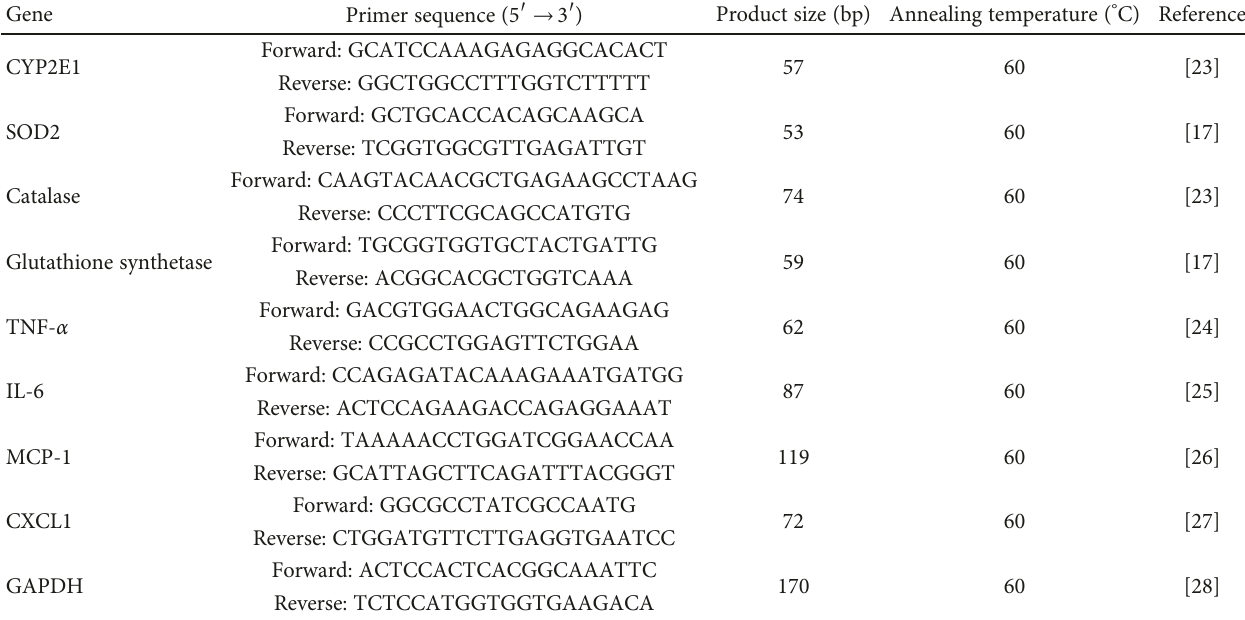
Table 1: Primers used for quantitative real-time RT-PCR. Gene Primer sequence (5 ′ → 3 ′